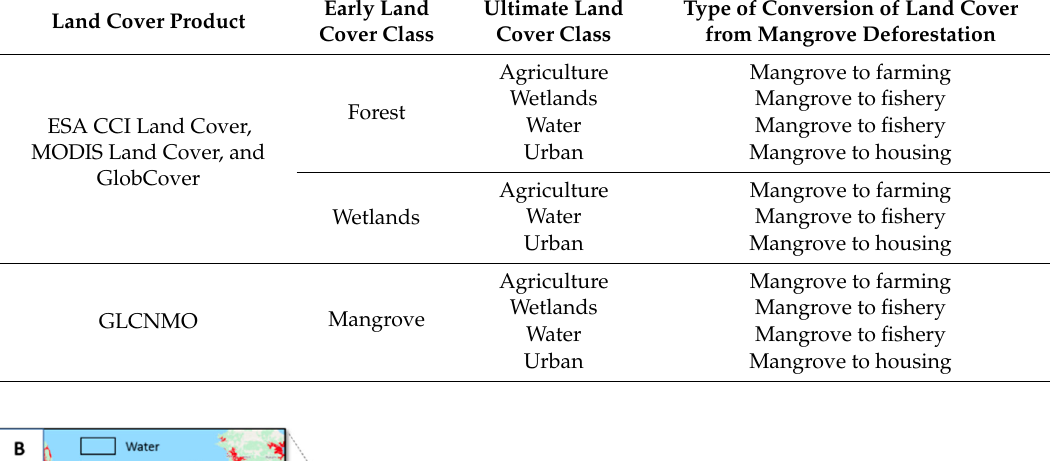
Table 4. Classes of each land cover product defined in the “mangrove forest” class.